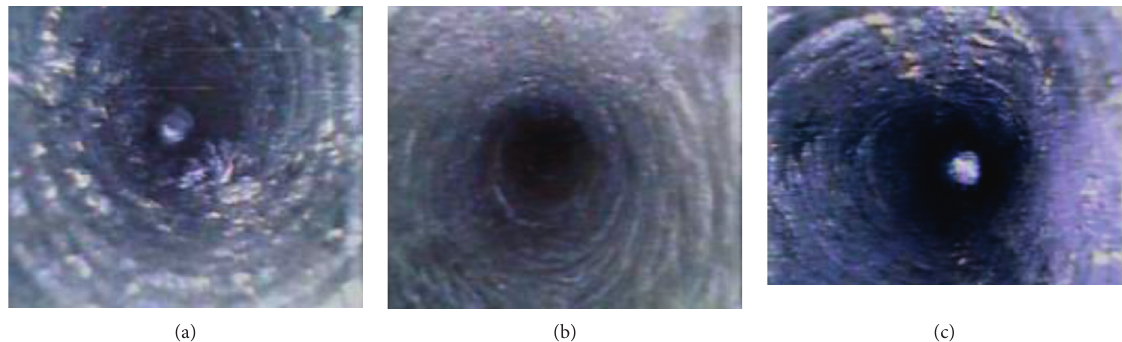
Figure 11: Internal fracture development in the coal mass. (a) Front-end crushing zone, (b) middle intact zone, and (c) back-end anchorage zone.